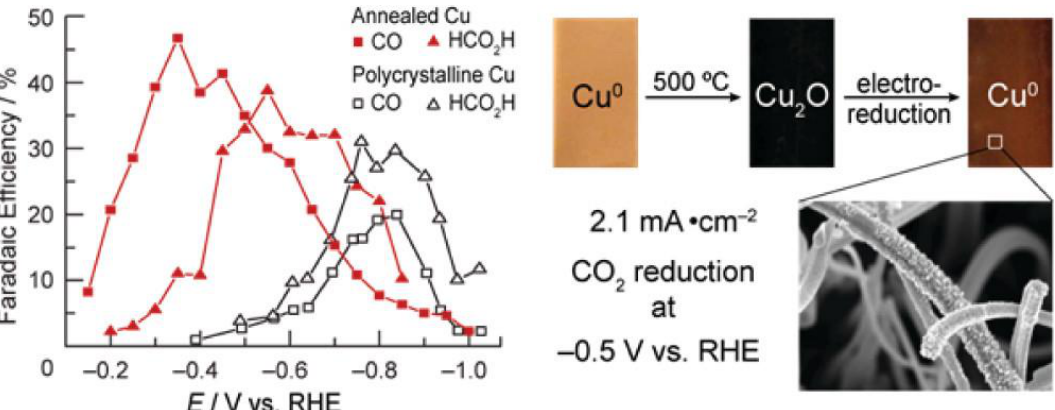
Figure 3. Electrocatalytic performance and the preparation process of Cu electrodes. Reprinted from Ref. [109], copyright (2012), with permission from the American Chemical Society.